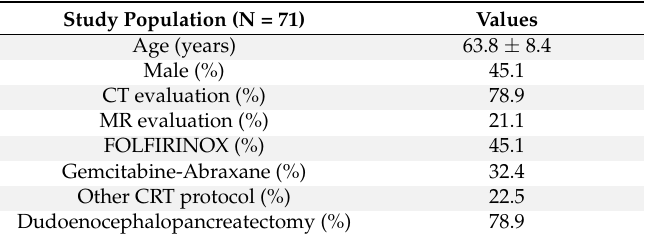
Table 1. Main characteristics of the study population.